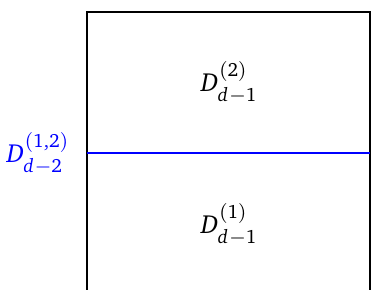
is a codimension-2 topological to D p 2 q from D p 1 q d ´ 1 d ´ 1 d ´ 2 . To specify and D p 2 q d ´ 1 d ´ 1